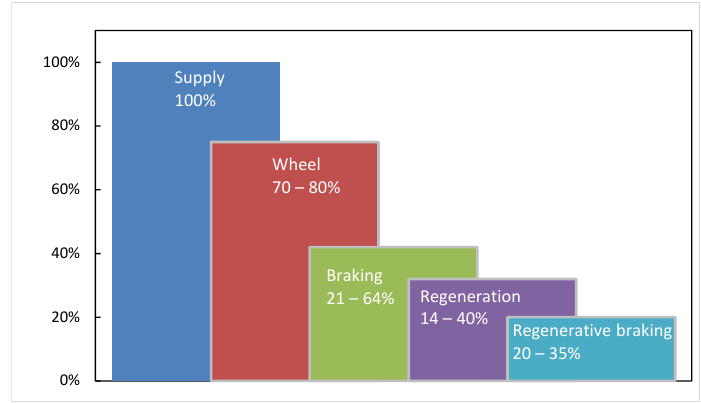
Figure 9. Distribution of braking energy at regeneration.